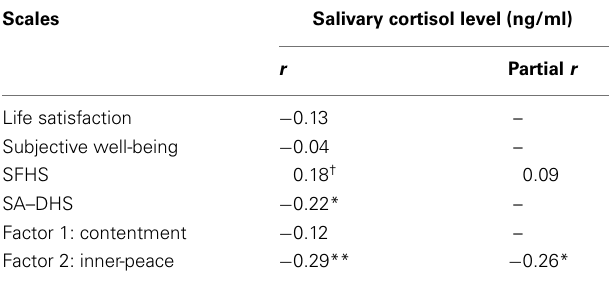
Table 5 | Correlations between salivary cortisol and happiness and well-being measures (Sample F).